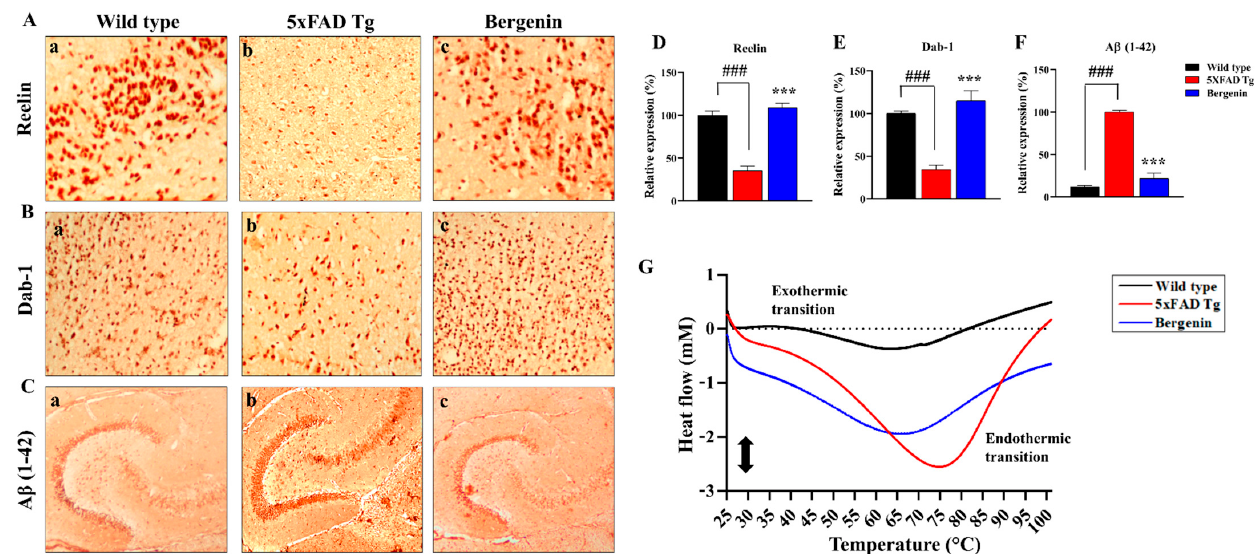
Figure 7. Bergenin demonstrated the protective effect through the Reelin-signaling pathway by inhibiting β -aggregation. Immunohistochemical analysis of ( A ) Reelin, ( B ) Dab-1 and ( C ) A β (1–42) in the hippocampal region of ( a ) wild-type, ( b ) 5xFAD Tg, and ( c ) Bergenin-treated groups. ( D – F ) Represents quantitative analysis of (%) relative expression of proteins. Scale bar = 50 µm. Results were expressed as mean ± S.D. *** p < 0.001 versus the 5xFAD Tg group, ### p < 0.001 versus the wild-type group. ( G ) DSC heating scans (25–100 °C) displaying thermal transitions in hippocampal regions of the mouse brains in wild-type, 5xFAD Tg, and Bergenin groups.